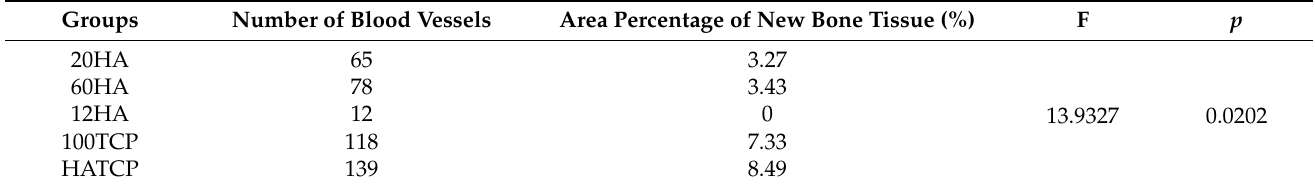
Table 1. The correlation between the number of blood vessels and the area percentage of new bone tissue.